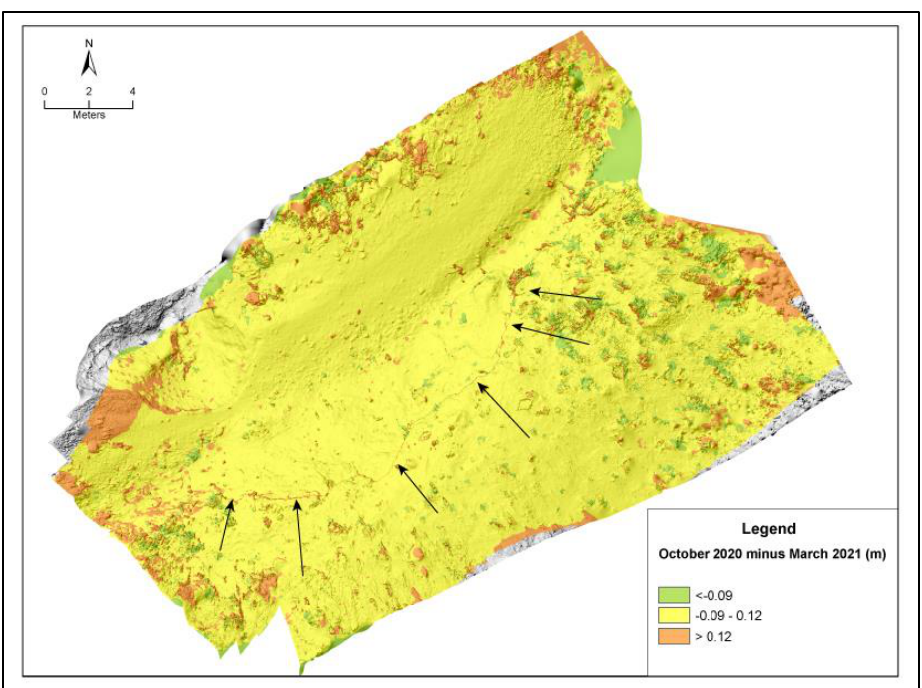
Figure 8. Differences between the October 2020 and the March 2021 UAV–derived DSMs from Kechries site two. A major active curved scarp is visible in the central part of the slope. The SW and NE parts of the scarp appear to have been more active, showing higher displacement. Black arrows indicate possible cracks in the soil surface.